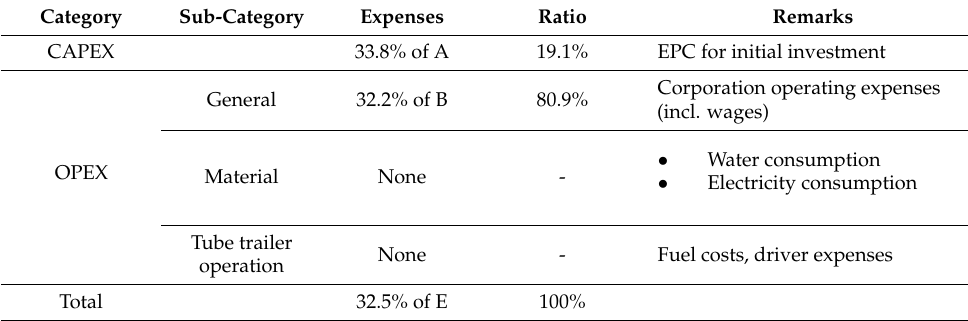
Table 47. Estimation of whole expenses and breakdown.